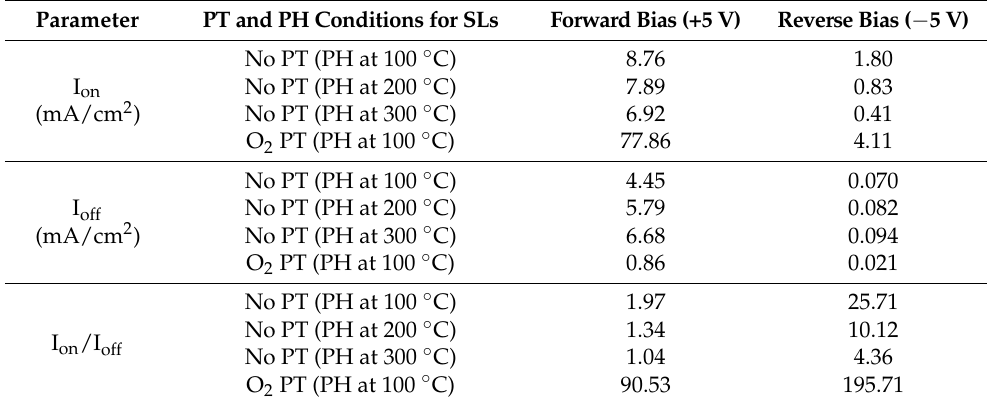
Table 4. Summary photocurrents, dark currents, and on-off current ratios at bias conditions of +5 and − 5 V measured from the p-Si/n-ZnO-NR heterojunction PDs. Parameter PT and PH Conditions for